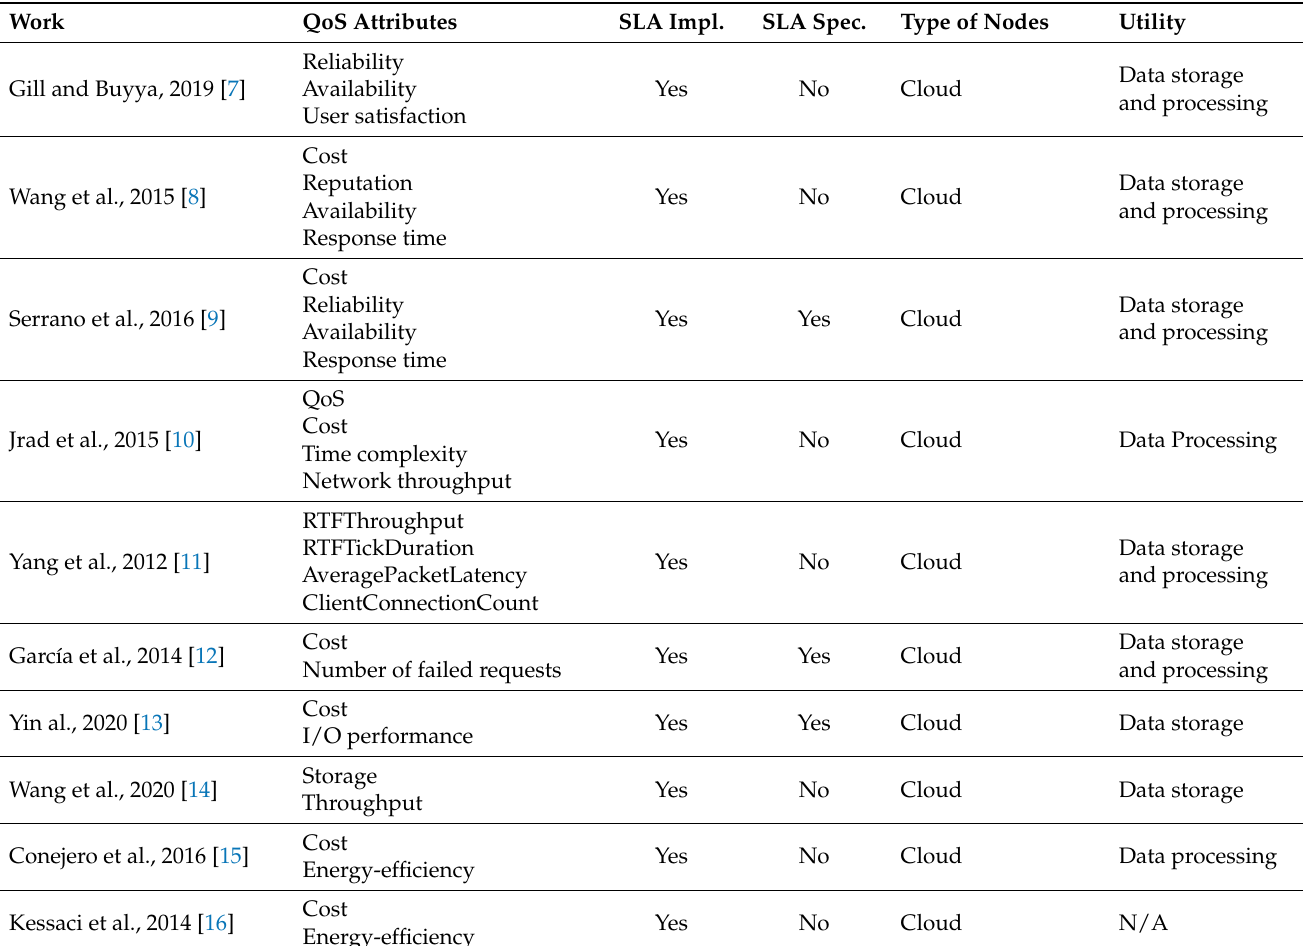
Table 1. State-of-the-Art analysis summary for Fog storage. Works are compared with respect to the QoS attributes, the SLA implementation, the SLA specification, the type of nodes and the